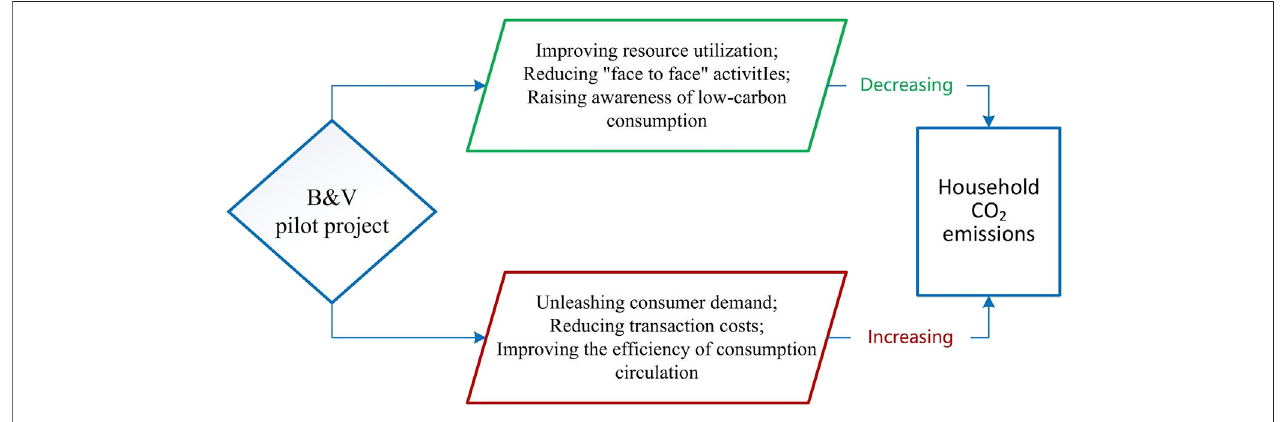
FIGURE 3 | Transmission mechanism of B&V pilot project and rural HCE